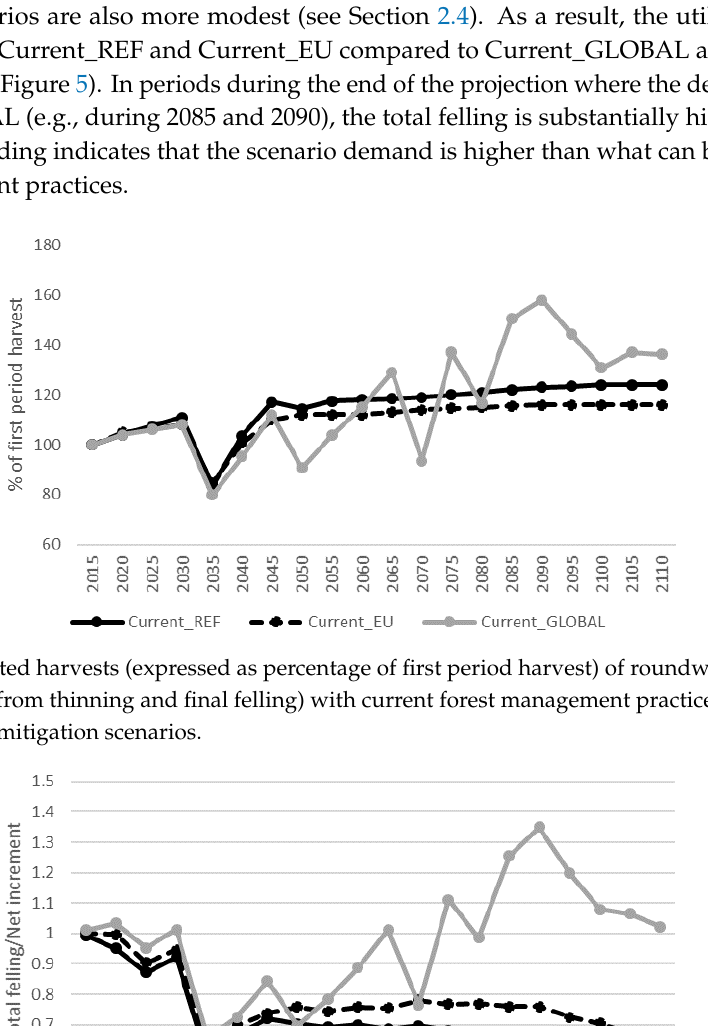
Figure 5. Projected utilization rates (total felling in PCTs, thinning and final felling / net increment) on the net area used for wood production (84.6% of the productive forestland, set-asides and retention areas in production stands are not included) with current forest management practices in the three climate change mitigation